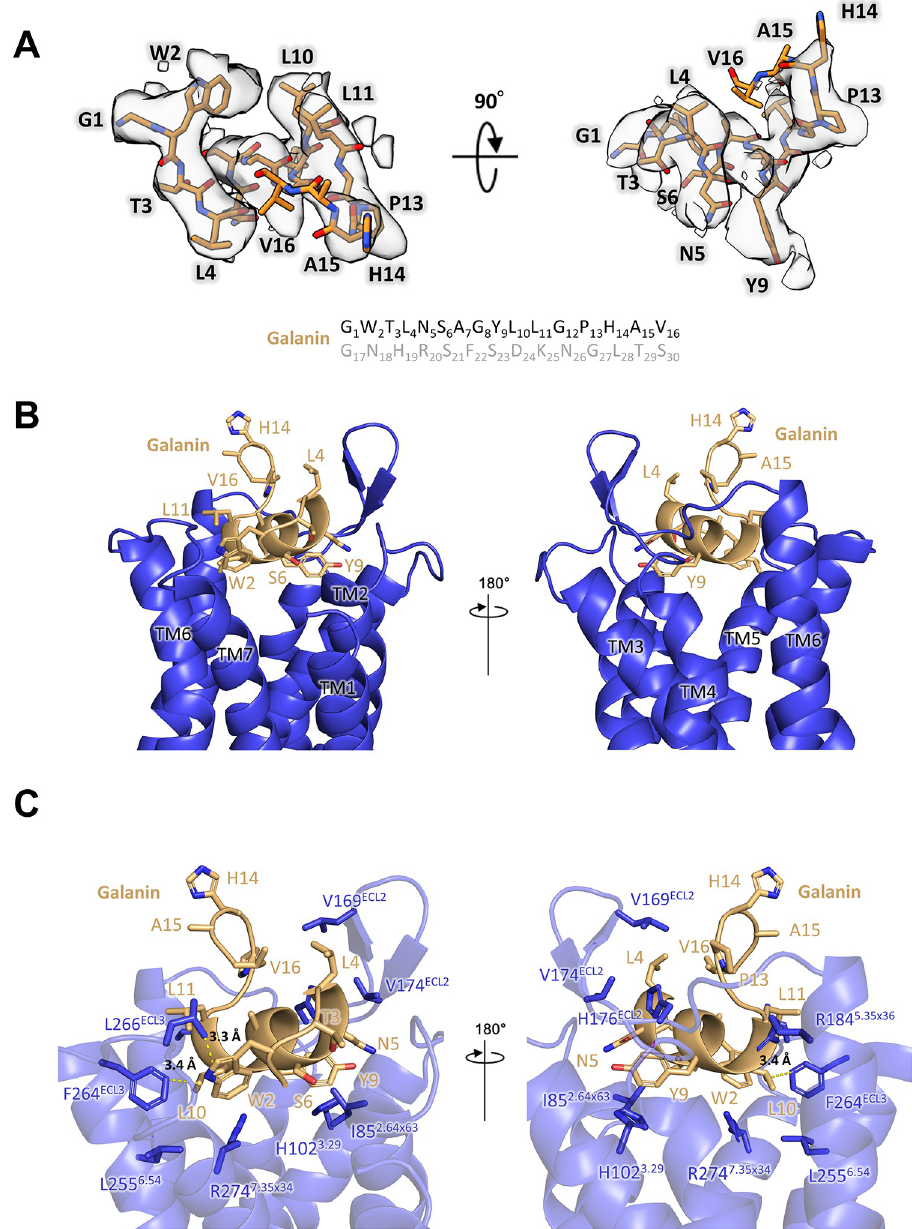
Fig 2. Galanin recognition of GALR2. (A) The cryo-EM map near the galanin ligand in 2 different orientations. The sequence of galanin is written below, and the C-terminal 14 amino acids, which are not visible in the map, are colored in gray. (B) The ligand binding pocket of GALR2 with galanin is shown in 2 different orientations. GALR2 is shown as a ribbon diagram, and galanin as a ribbon diagram and stick model. (C) Detailed interactions between galanin and GALR2. The hydrophobic interactions between Leu10 P and Phe264 ECL3 and Trp2 P and Leu266 ECL3 are indicated with yellow dotted lines. cryo-EM, cryo-electron